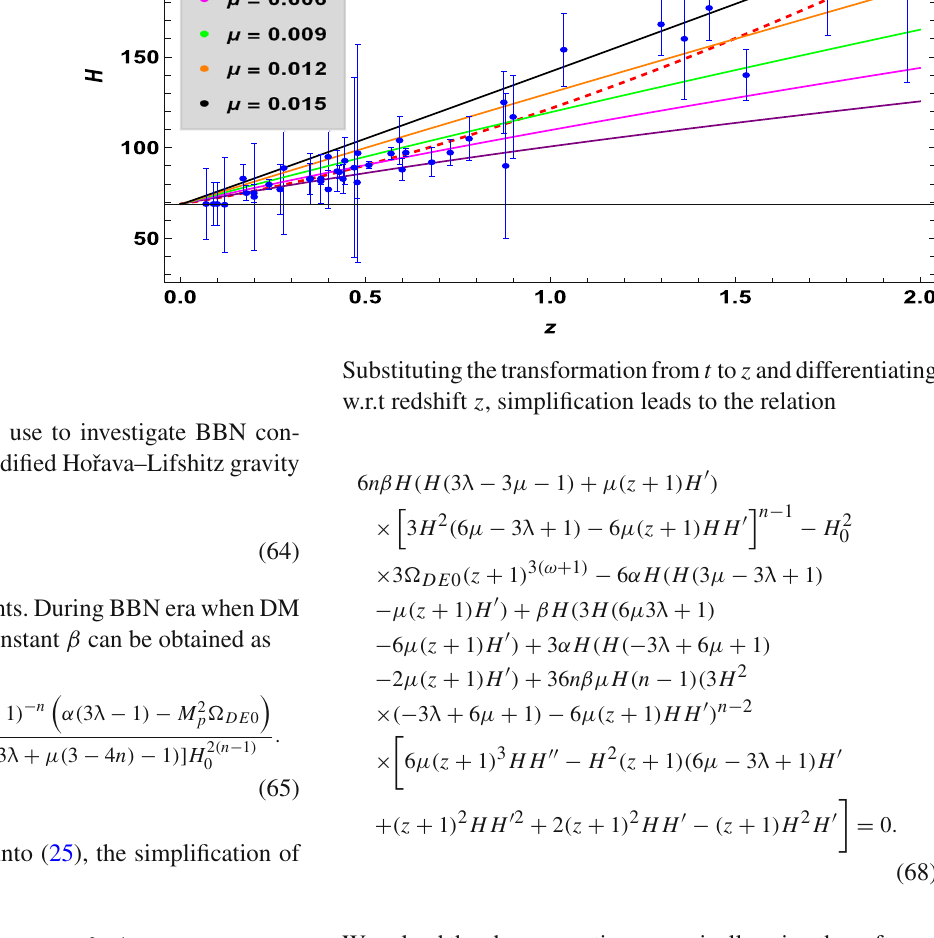
Fig. 8 Graph Hubble parameter H against redshift z for different values of μ = 0 . 003 (purple), 0.006 (magenta), 0.009 (green), 0.012 (orange), 0.015 (black). The dashed red line relates to the (cid:2) CDM regime. The error bars represent the observational values. In plotting the figures, we have chosen H 0 = 69 , H (cid:6) ( 0 ) = 1 , λ = 0 . 31 , ω = − 1 / 3 , (cid:15) DE 0 = 0 . 7 and α is given in Eq. (60)